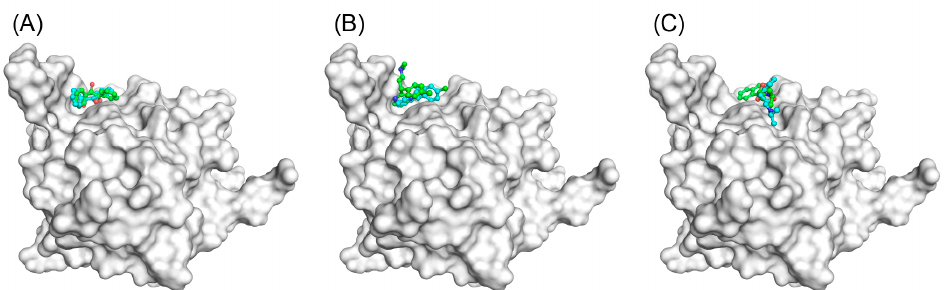
Figure 2. Docking structures of cAGP with ( A ) benzoin, ( B ) chlorpheniramine and ( C ) propranolol enantiomers. The built model structure of cAGP was illustrated as surface mode and the docked enantiomers were shown as ball-and-stick models, respectively.